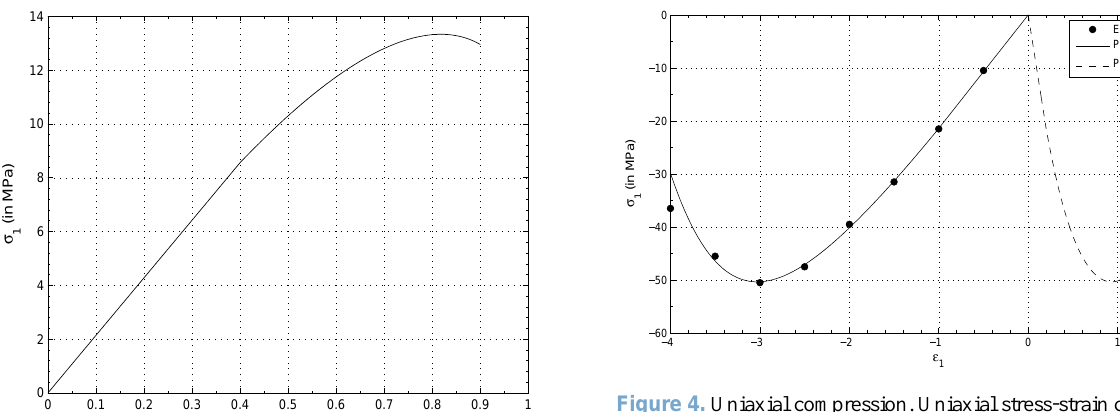
Figure 4. Uniaxial compression. Uniaxial stress-strain curve.